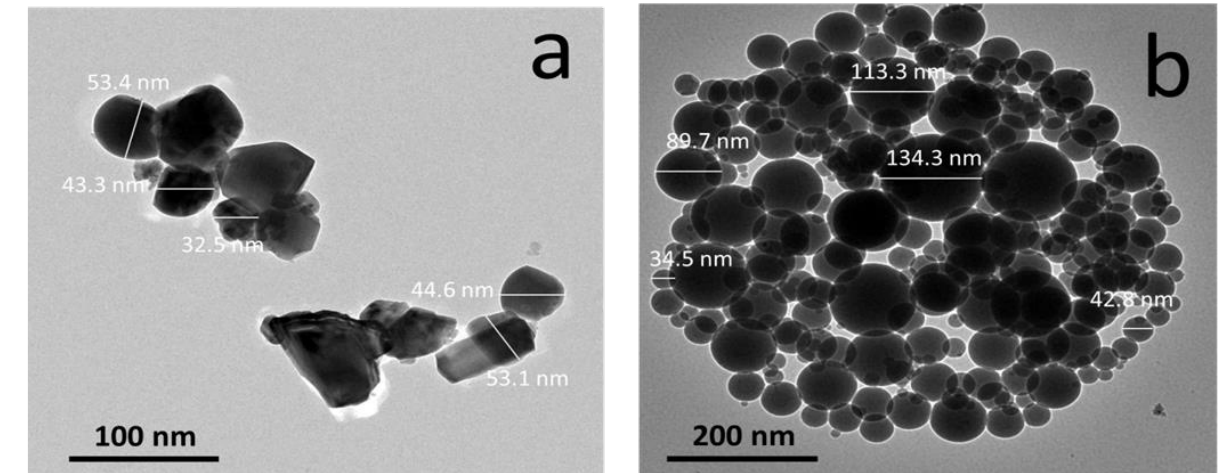
Figure 3. TEM images of ( a ) Y element and ( b ) Silica fume.